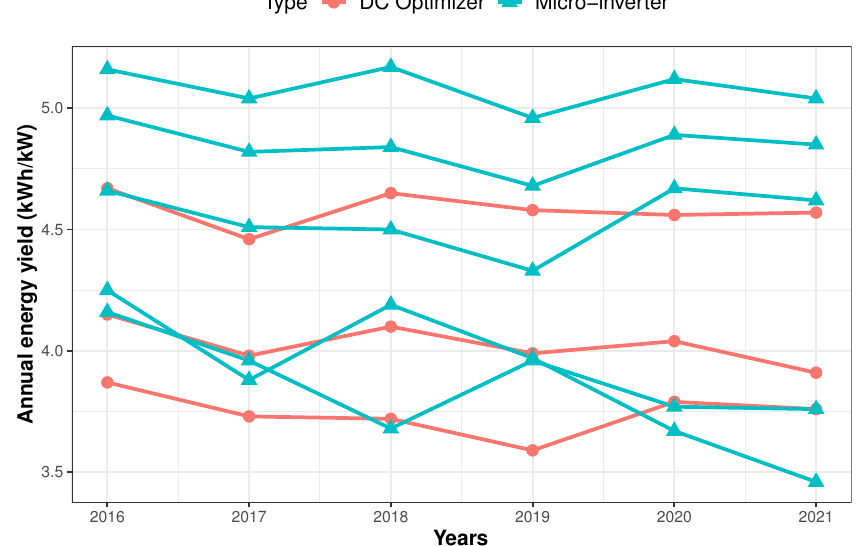
Figure 5. The plot of the annual energy yield of PV stations in Table 2 from 2016 to 2021 which were used for the annual degradation rate